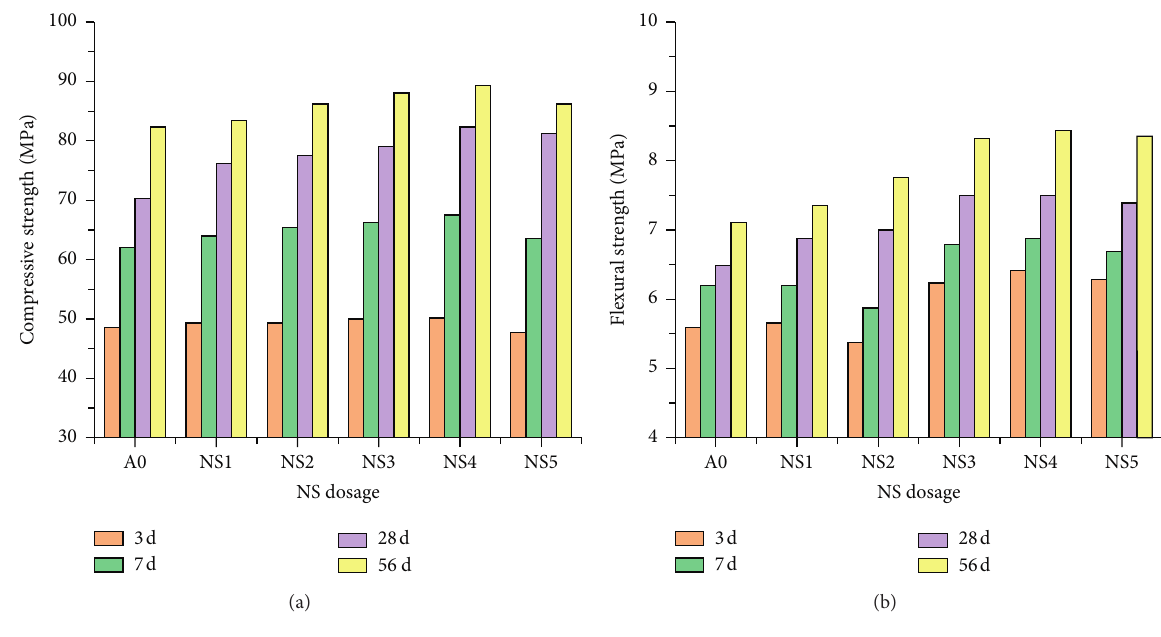
Figure 2: Effect of NS on AAM compressive strength (a) and flexural strength (b).